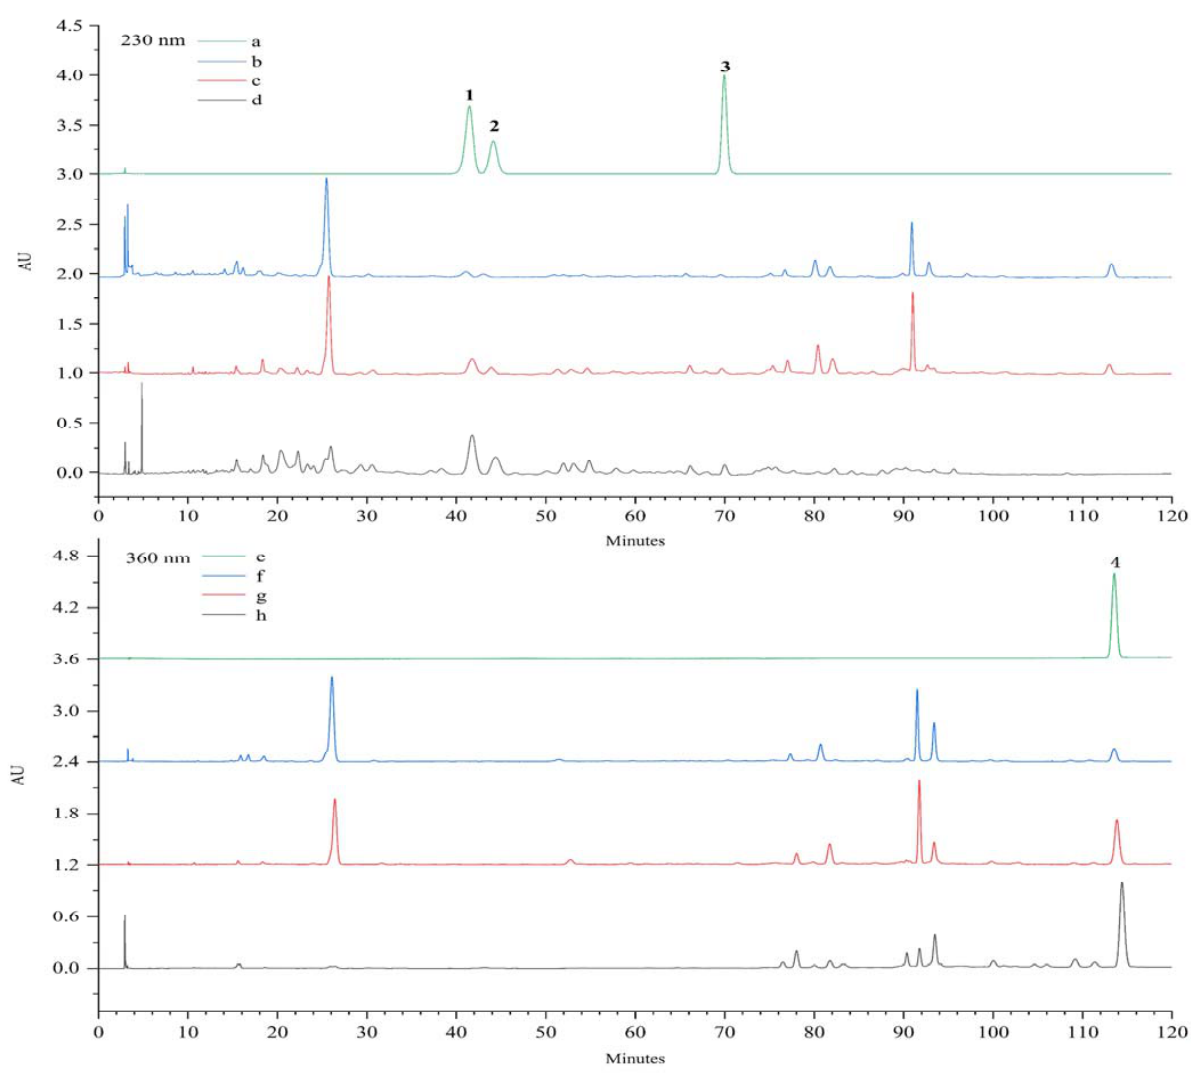
Figure 7. HPLC chromatograms of the standard compounds 1 – 3 ( a ), V. amurensis extract ( b ), P ‐ TLF ( c ) and total lignans ( d ) at 230 nm. HPLC chromatograms of the standard compound 4 ( e ), V. amurensis extract ( f ), P ‐ TLF ( g ) and total flavonoids ( h ) at 360 nm.